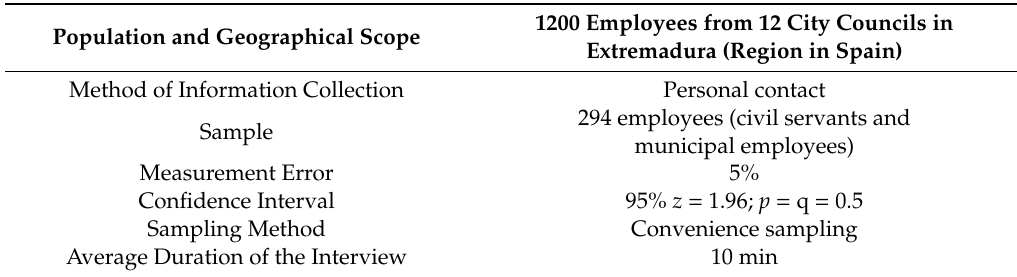
Table 2. Technical data